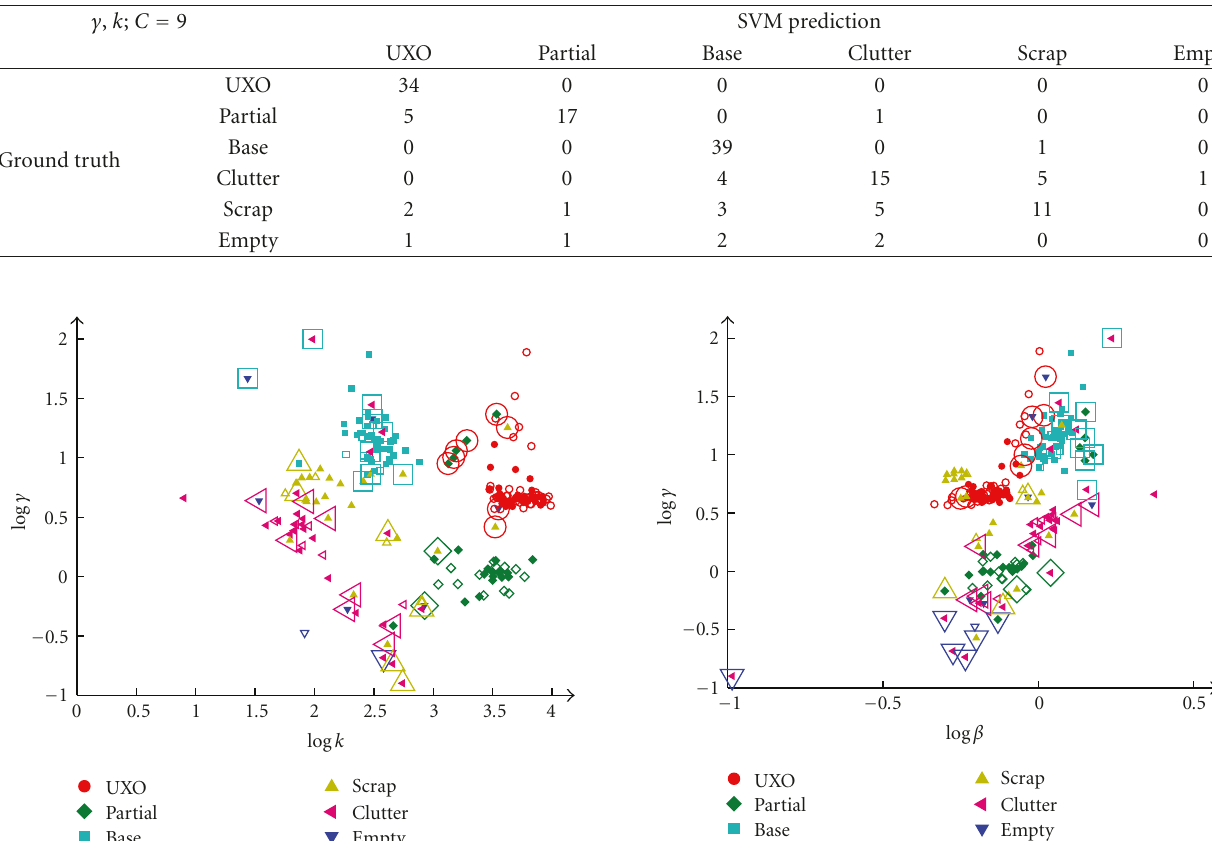
Table 2: SVM classification of Camp Sibert anomalies using γ and k with C = 9.